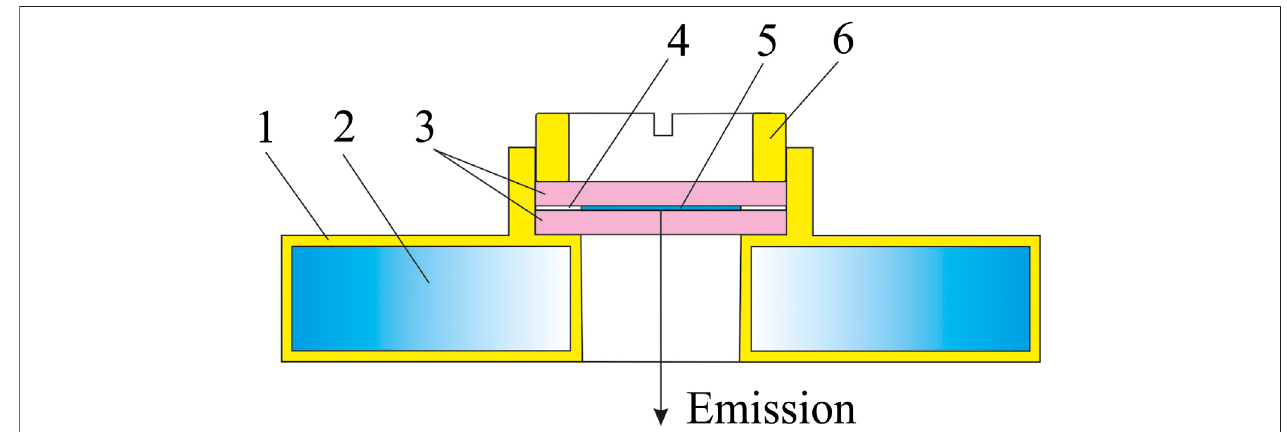
FIGURE 3 | Cuvette with a thermostatic holder for measuring emission IR spectra: 1 – thermostatic jacket, 2 – channel for liquid fl ow at a set temperature, 3 – cuvette windows, 4 – PTFE spacer, 5 – liquid sample, 6 – screw down cover.